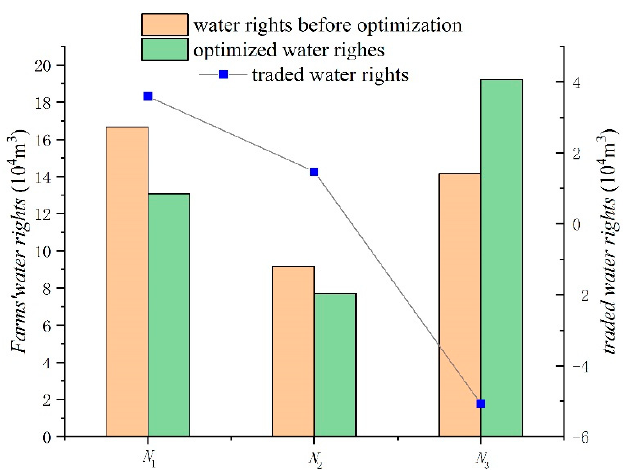
Figure 8. The tradable water volume among irrigation water users under the optimized scheme M3.